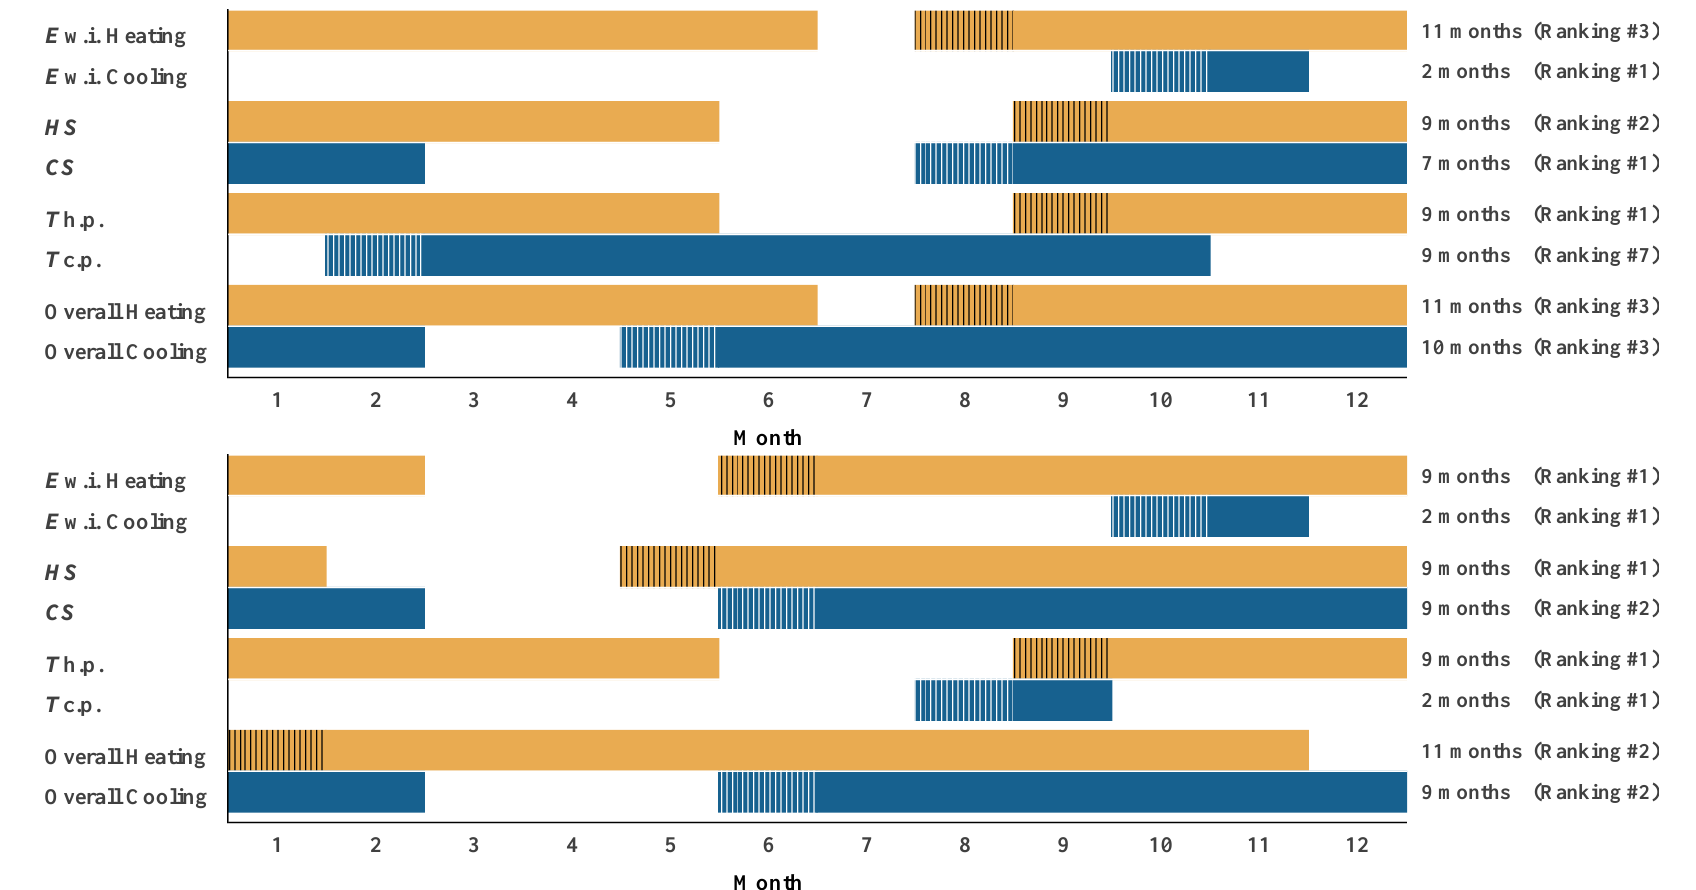
Figure 11. Comparison of the best periods for unit #503 (upper) and unit #601 (lower).